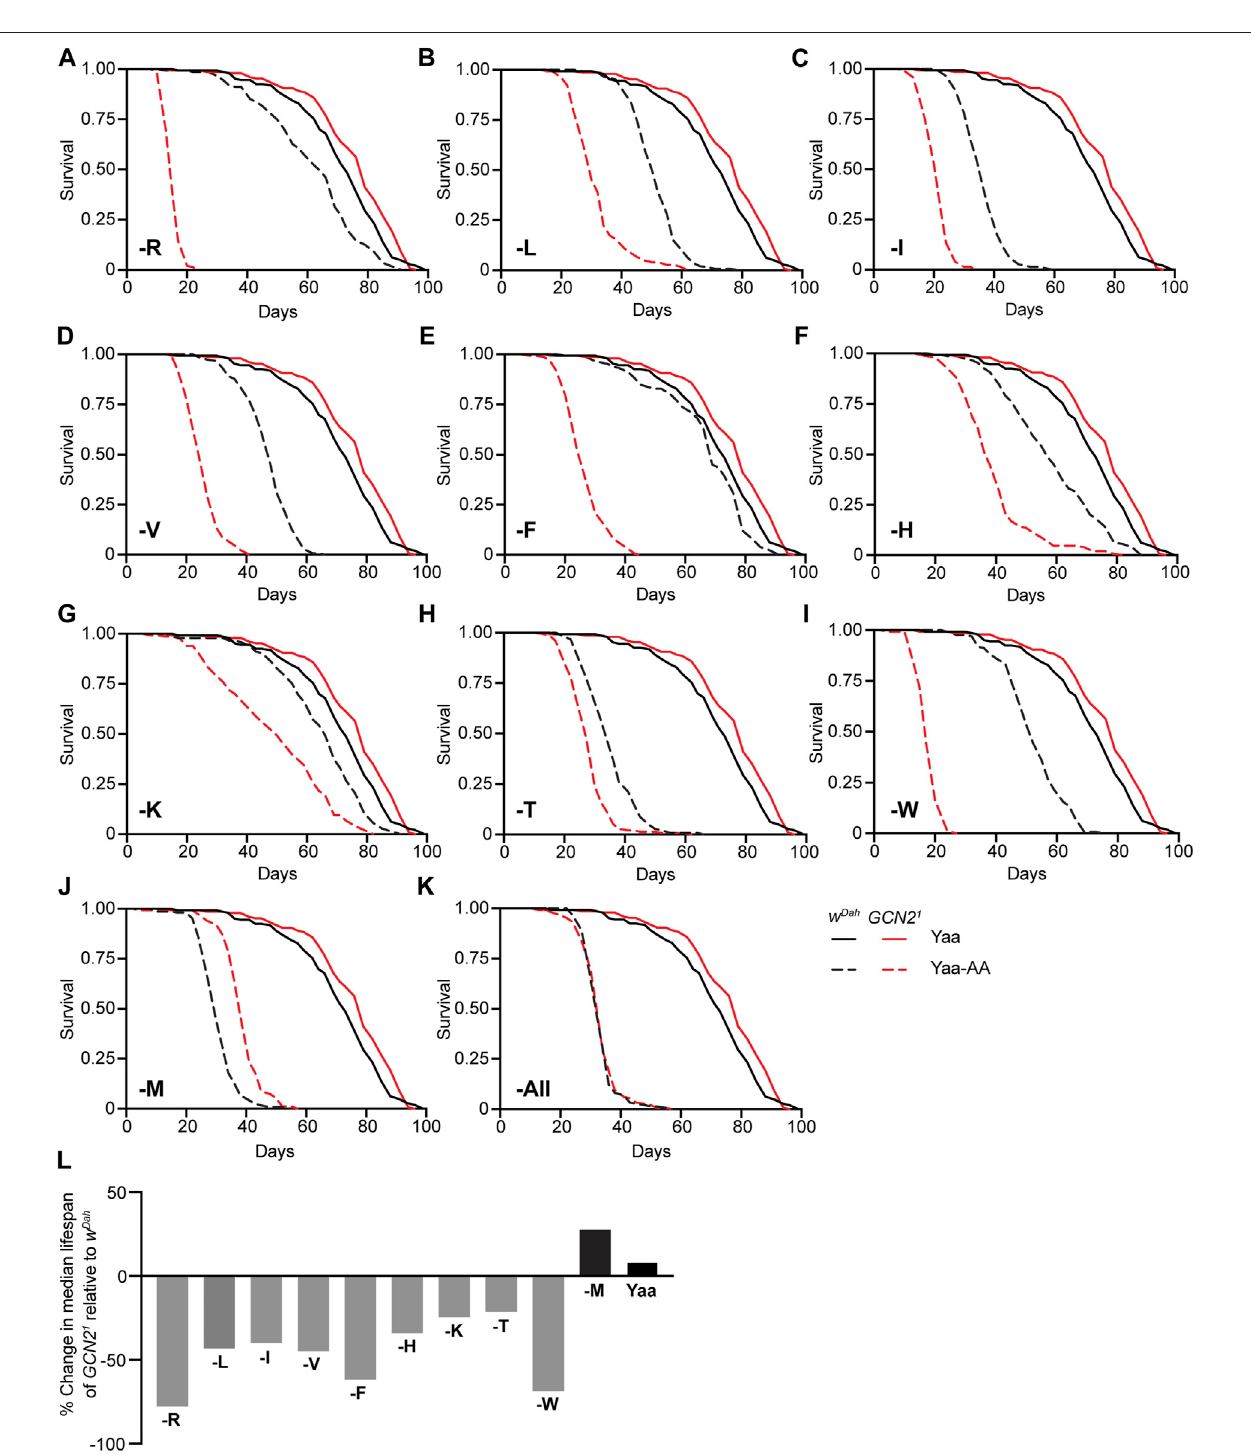
FIGURE 2 | GCN2 function is essential for survival under deprivation of individual EAA except for methionine. (A – K) Survival of w Dah control and Gcn2 1 mutant female fl ies under full deprivation of individual EAA (A – J) and all amino acids (-All) (K) . Gcn2 1 mutants showed signi fi cantly increased lifespan compared to w Dah fl ies on the Yaa diet ( p = 7.8 × 10 − 3 , log-rank test). Survival of Gcn2 1 mutants was signi fi cantly reduced compared to w Dah on -R ( p = 6.0 × 10 − 73 ) (A) , -L ( p = 2.9 × 10 − 41 ) (B) , -I ( p =9.9×10 − 63 ) (C) ,-V( p =1.9×10 − 64 ) (D) ,-F( p =1.3×10 − 67 ) (E) ,-H( p =2.4×10 − 25 ) (F) ,-K( p =1.4×10 − 12 ) (G) ,-T( p =5.3×10 − 15 ) (H) ,-W( p =3.6×10 − 72 ) (I) diets, log-rank test. In contrast, Gcn2 1 mutants were signi fi cantly longer lived than w Dah control fl ies on M deprived medium ( p = 4.4 × 10 − 25 , log-rank test) (J) . Under deprivationofallaminoacids (K) , Gcn2 1 mutantshadasimilarlifespanthan w Dah fl ies( p =0.66,log-ranktest).Survivalcurvesof w Dah and Gcn2 1 mutantsontheYaadiet arethesamein (A – K) . (L) Summaryofsurvivalanalysisrepresentedaspercentagechangeinmedianlifespanof Gcn2 1 mutantsrelativeto w Dah controlsoneachdiet. n = 150 fl ies for each condition of each genotype.